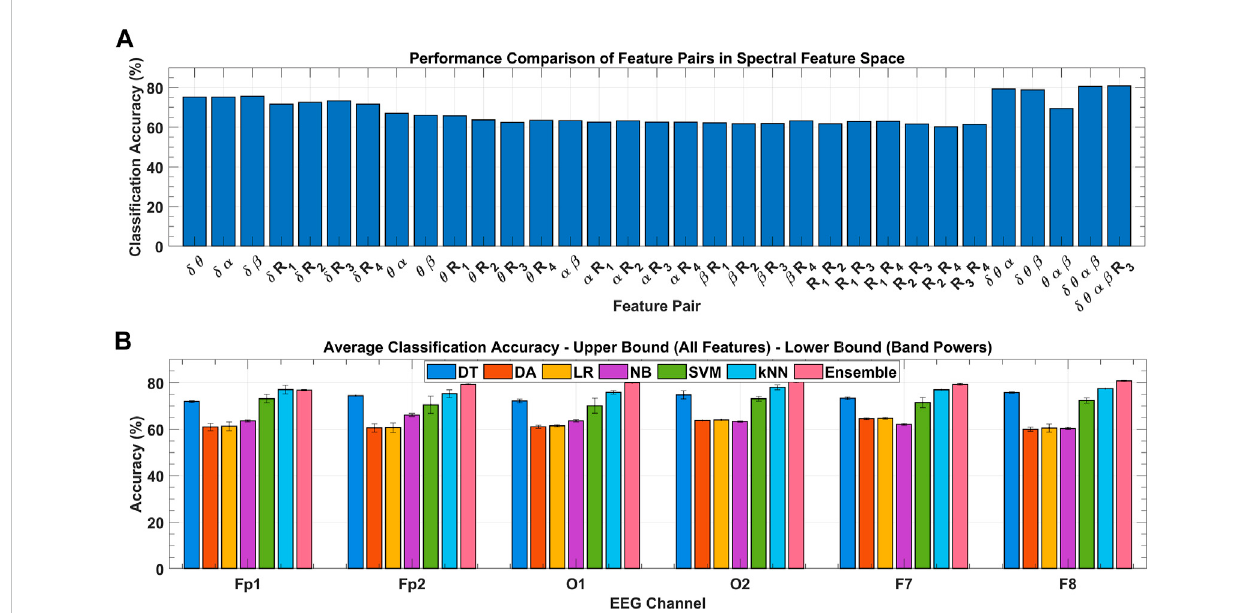
FIGURE 9 (A) Classi fi cation performance comparison among feature combinations of spectral feature space for the F8 channel with ensemble classi fi er over all subject ’ s data. (B) Classi fi cation performance comparison among various classi fi ers for the F8 channel over all subject ’ s data with variance bounds obtained with varying feature